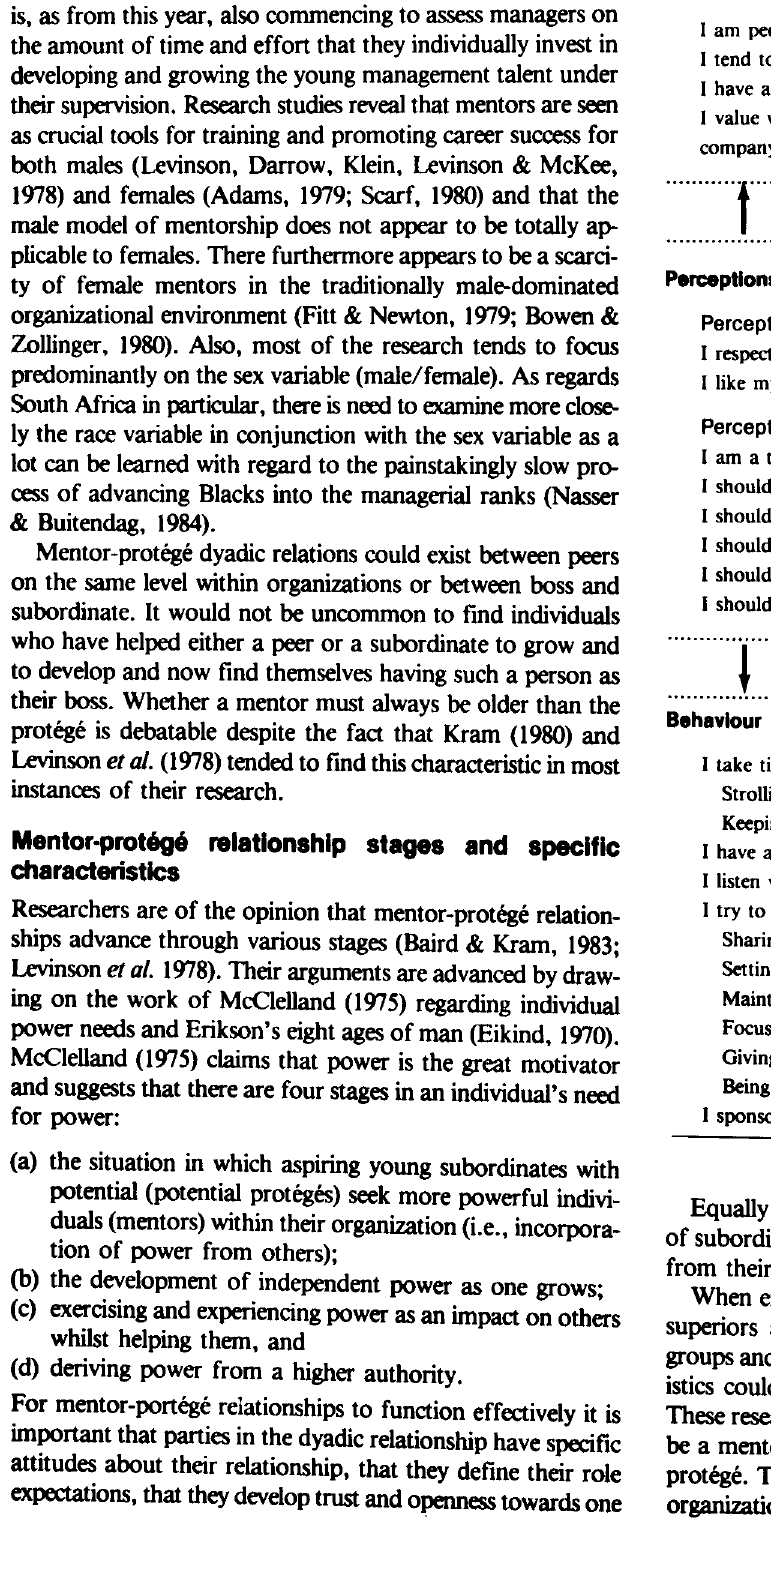
Table 1 Characteristics of effective superiors Psychologlcal